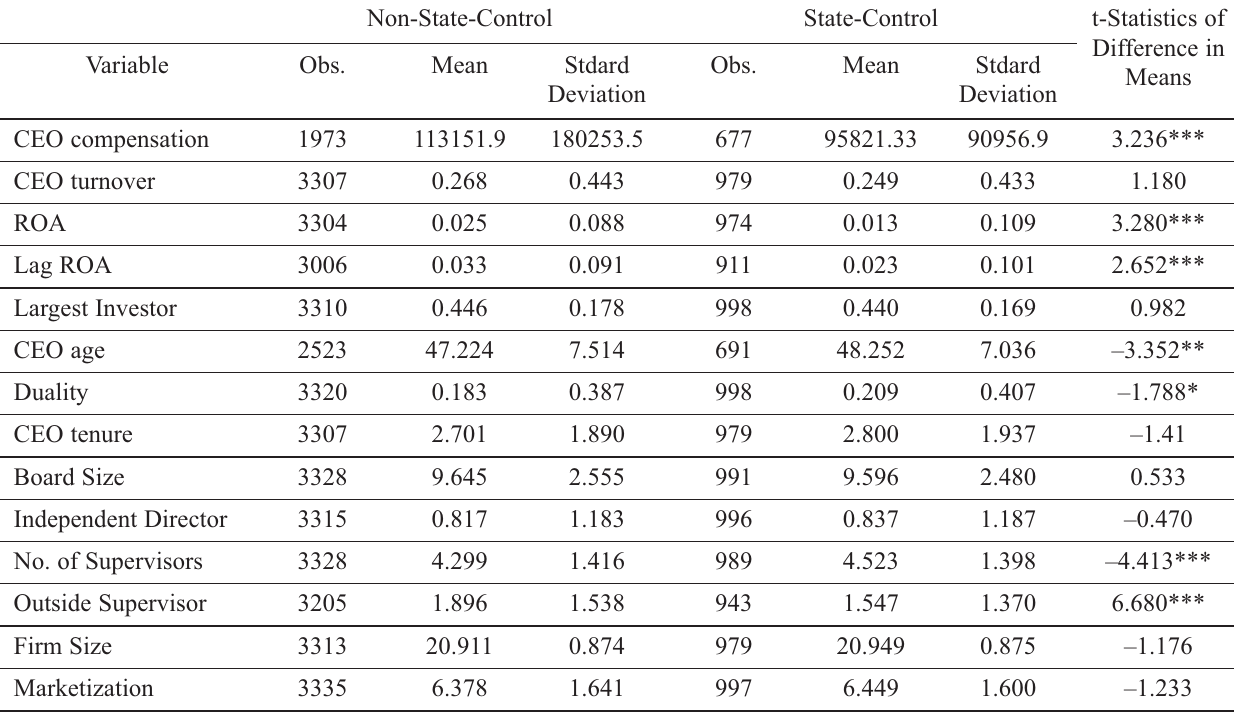
Table 2. Summary statistics for state-controlled and non-state-controlled fi